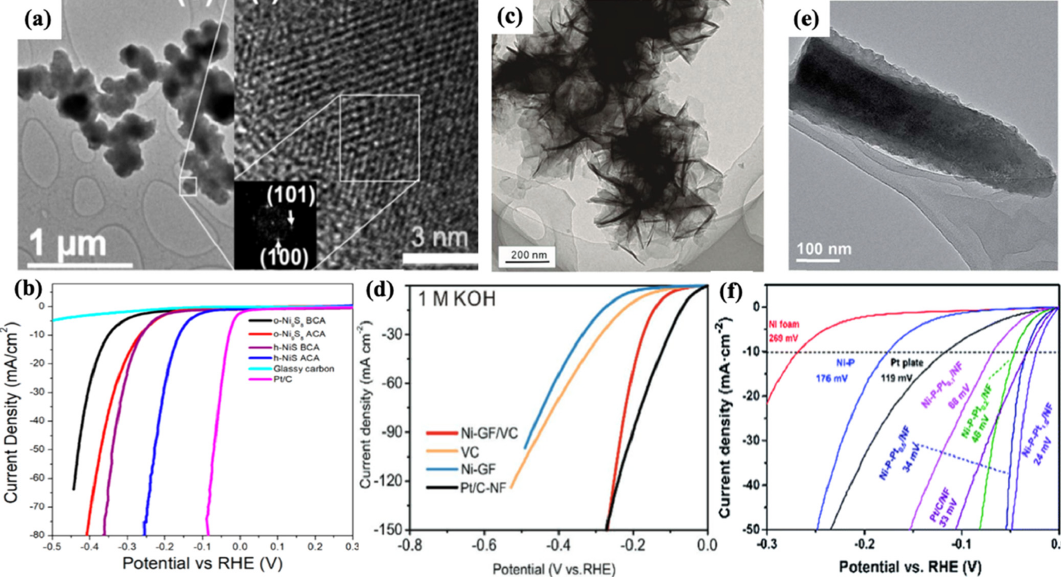
Figure 11. ( a ) SEM and HRTEM image of h-NiS. ( b ) HER-LSV curves of o -Ni 9 S 8 and h -NiS, reprinted with permission from Ref. [73]. ( c ) HRTEM images and ( d ) HER performance of the Ni-GF/VC catalyst, reprinted with permission from Ref. [71]. ( e ) TEM image and ( f ) LSV curves of Ni-P-Pt/NF catalysts for the HER in 1 M KOH aqueous solution with iR correction, reprinted with permission from Ref. [76].